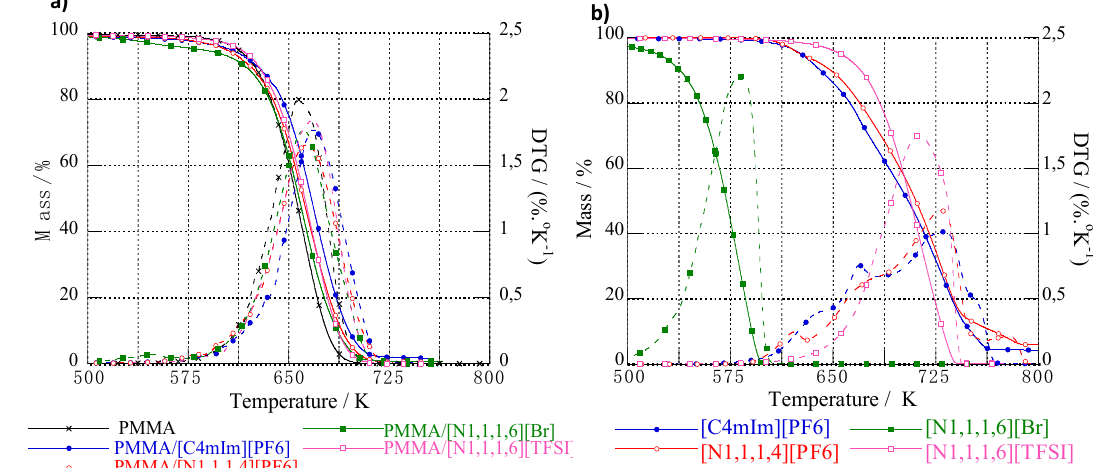
Figure 5. TGA ( a ) and DTG (first derivative) ( b ) traces of imidazolium- and ammonium-based ILs and IL-modified PMMA materials.